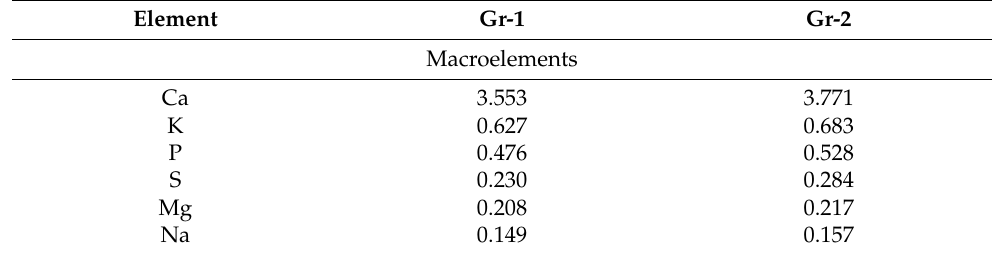
Table 2. The percentage of macro- and microelements in the feed mixture